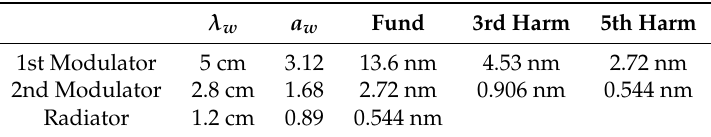
Table 2. Undulator parameters and radiation wavelengths for the High Harmonic Generation (HHG) seeded cascade. Electron beam energy = 2.2